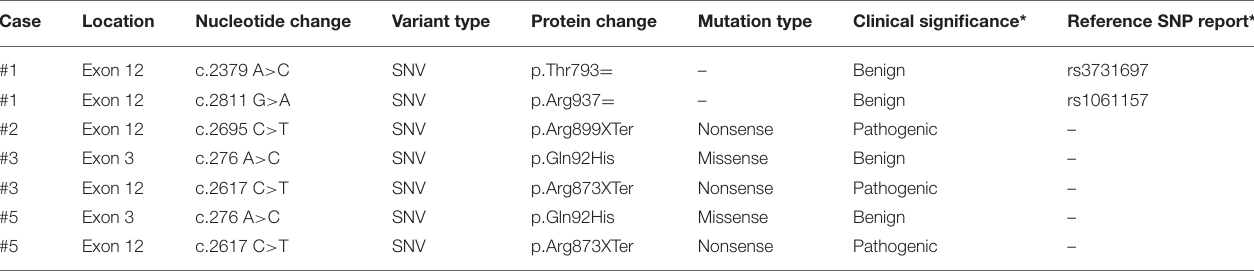
TABLE 3 | Description and annotation of BMPR2 mutations and polymorphisms detected using MinION sequencing for each case.